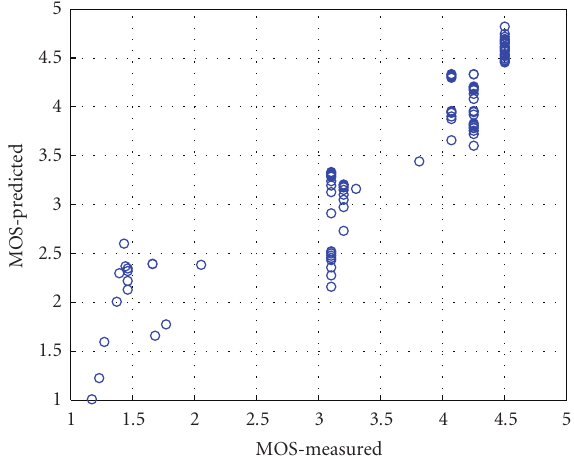
Figure 21: Predicted versus measured MOS results (regression- based).